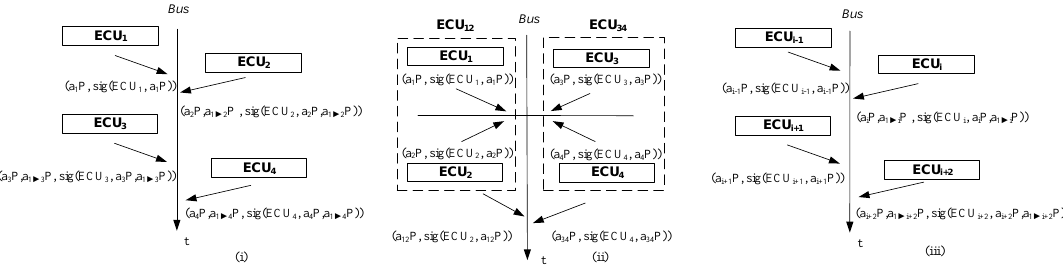
Figure 4. Overview of protocol procedures for DH-BLS ( i ), pairwise version of DH-BLS ( ii ) and tripartite Diffie–Hellman ( iii